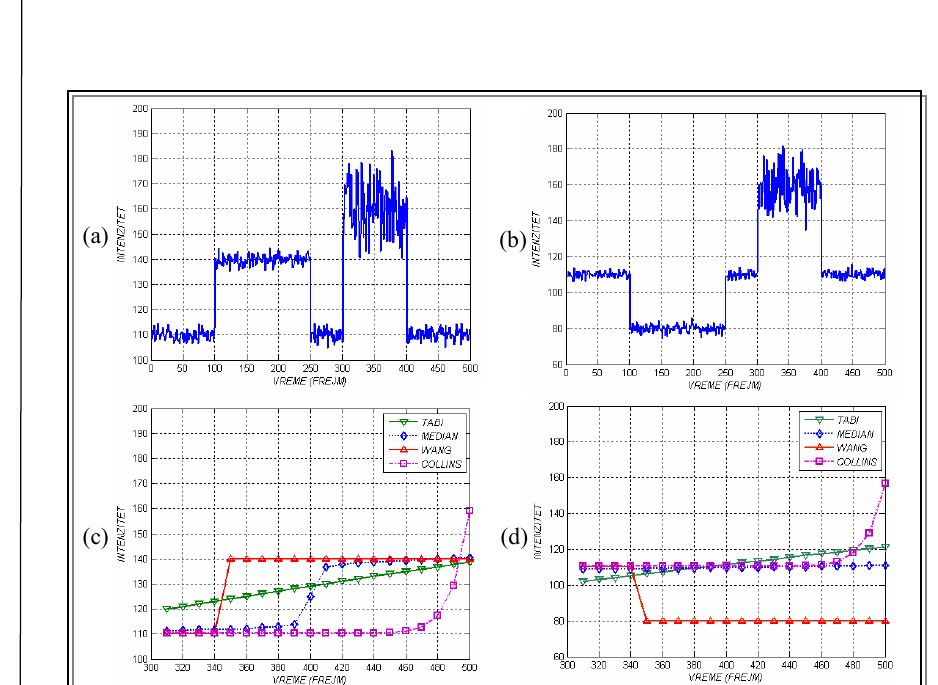
linearno raste sa vremenom otkrivanja drugog objekta. Koriš ć enjem sta- bilnih intervala pravilno se izdvaja slika pozadine sve dok je otkrivanje drugog objekta manje od 50 frejmova, nakon č ega se za sliku pozadine proglašava srednja vrednost nivoa sivog prvog objekta. Koriš ć enjem medijane na sl. 3c ispravno se izdvajaju vrednosti nivoa sivog pozadine sve dok je otkrivanje drugog objekta manje od 100 frejmova, nakon č ega se za sliku pozadine proglašava srednja vrednost nivoa sivog prvog objekta. Koriš ć enjem medijan е na sl. 3d ispravno se izdvajaju vredno- sti nivoa sivog pozadine za sve intervale otkrivanja drugog objekta. Iz sprovedenog eksperimenta vidi se da se najbolji rezultati izdvaja- nja slike pozadine dobijaju koriš ć enjem iterativnog postupka predloženog u [11,12], što je i bio razlog za njegovo prihvatanje u radu.